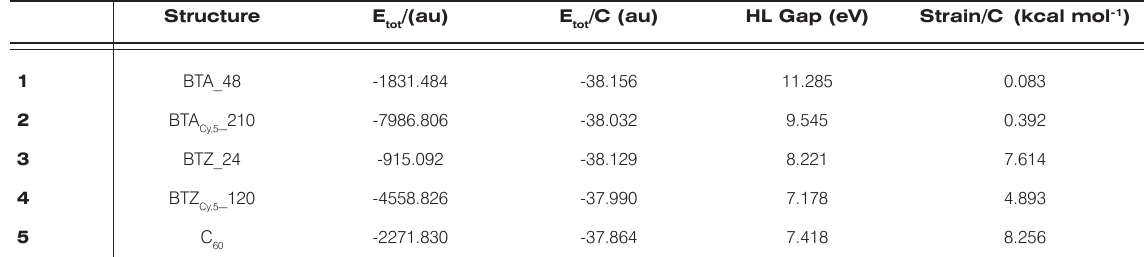
Table 2. Total energy E per Carbon atom and HOMO-LUMO HL Gap, at Hartree-Fock HF level of theory and Strain energy according to POAV tot theory in benzene-patched structures vs C taken as the reference. 60 Structure E /(au) E /C (au) HL Gap tot tot